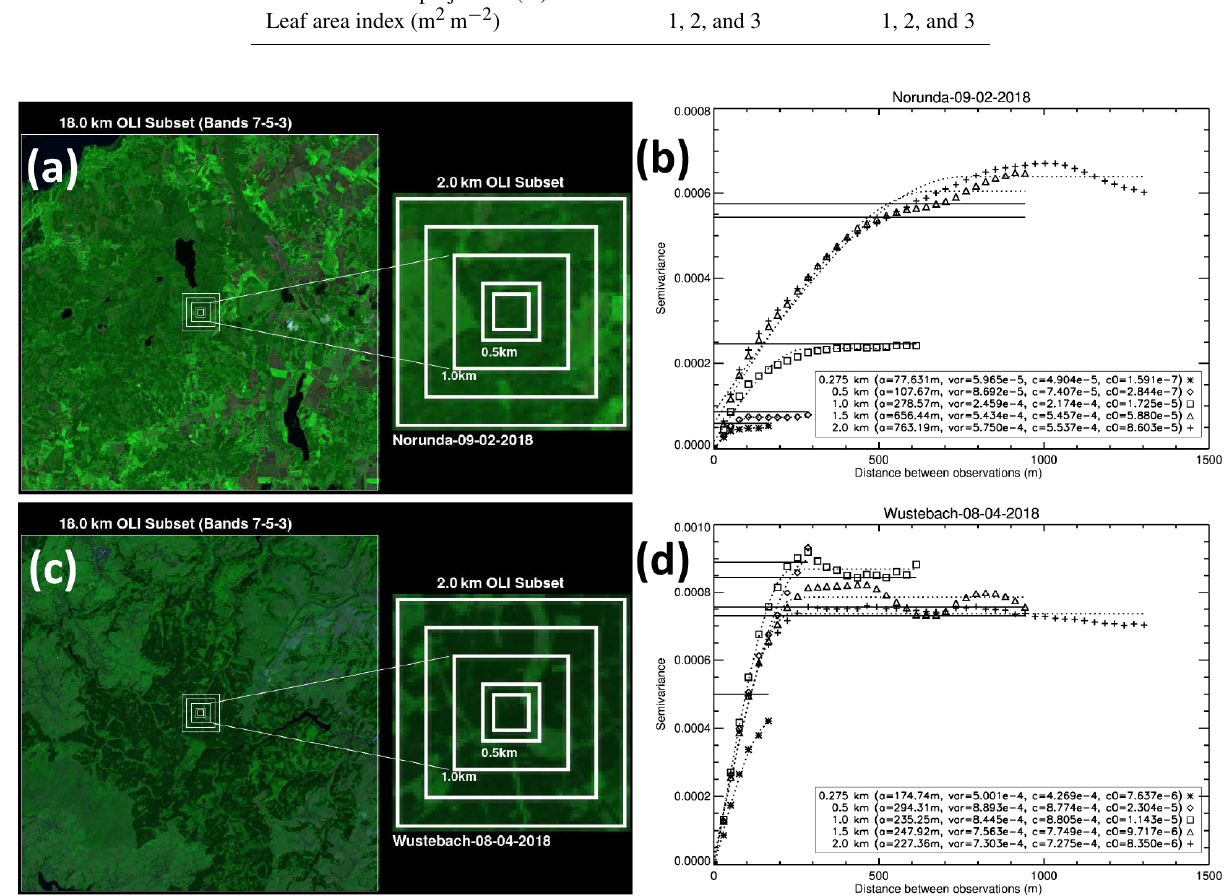
Figure 3. Shortwave BRF composites centered at ICOS sites of (a) Norunda in Sweden and (c) Wüstebach in Germany. (b, d) Variogram estimators (points), spherical model results (dotted curves), and sample variances (solid straight lines) obtained over the sites with Operational Land Imager (OLI) subsets and spatial elements of 0.275, 0.5, 1.0, 1.5, and 2km as a function of the distance between observations. Variogram legend explanations: a – variogram range; var – sample variance; c – variogram sill; c0 – nugget